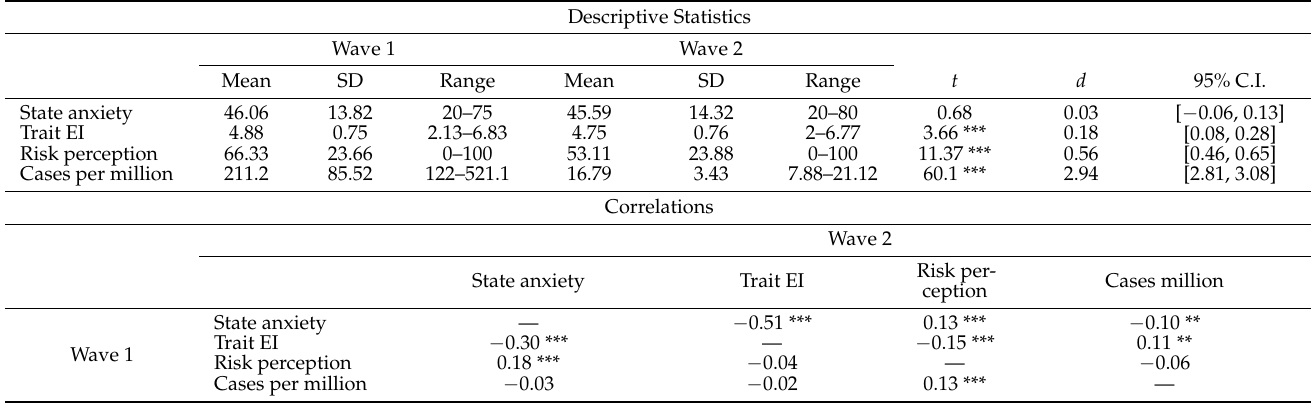
Table 2. Descriptive statistics, differences between wave 1 and wave 2, and correlations for wave 1 (below the diagonal) and wave 2 (above the diagonal).